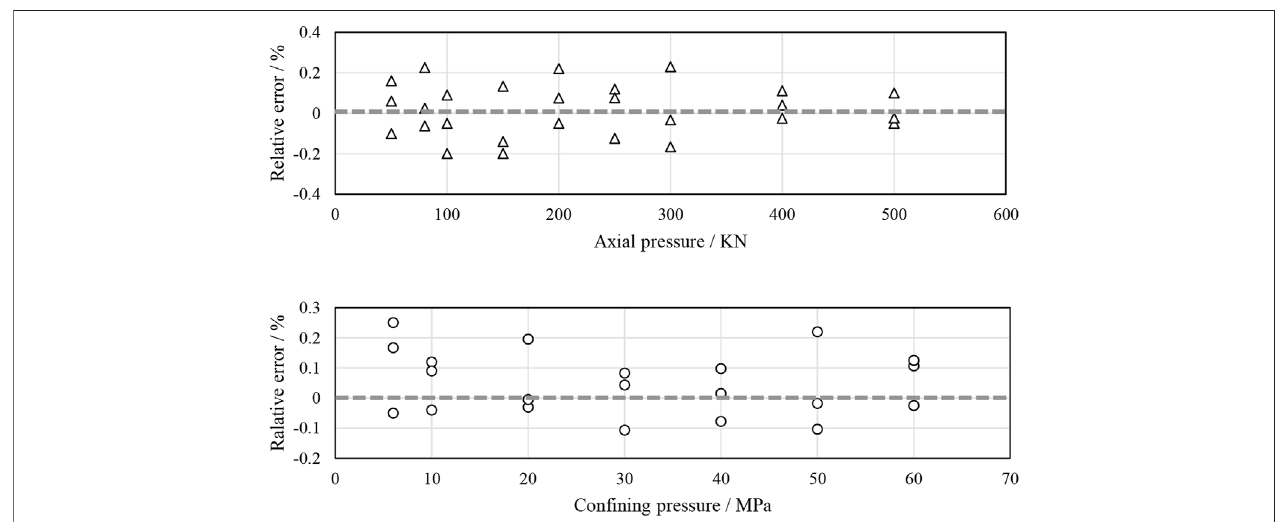
FIGURE 5 | Axial pressure and count rate of acoustic emission events as a function of time during the acoustic emission monitoring with a steel column sample.